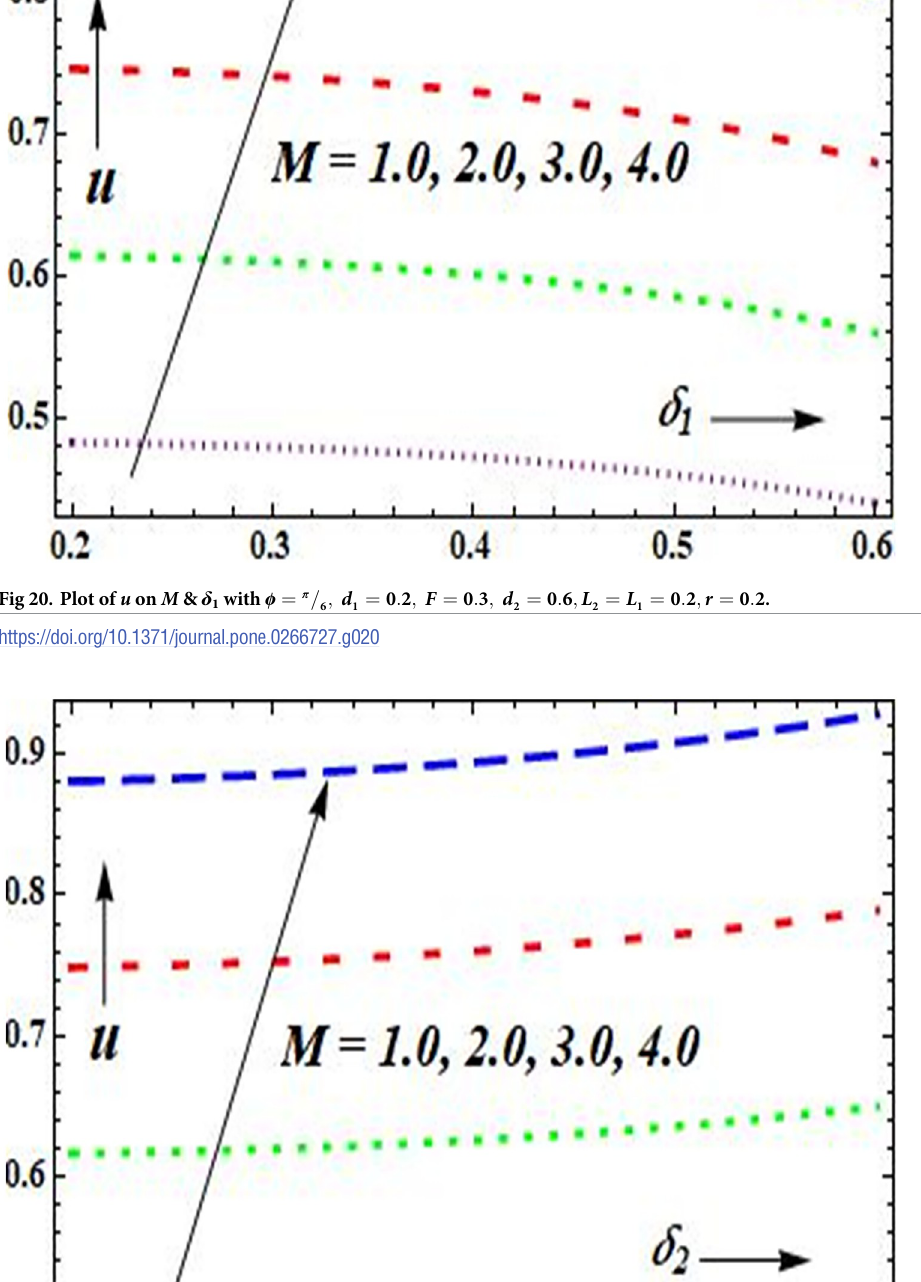
; d ¼ 0 : 2 ; F ¼ 0 : 3 ; d 6 1